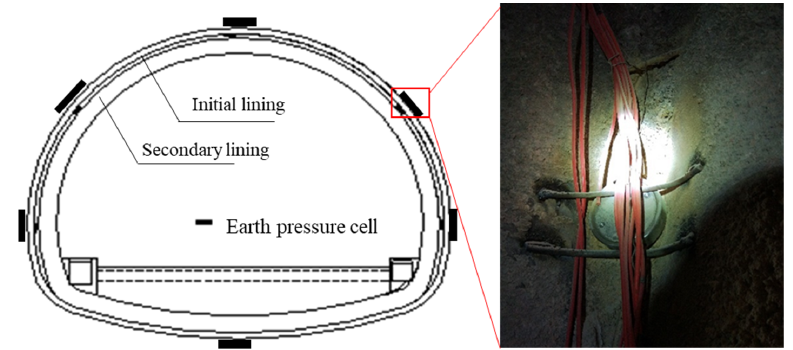
Figure 19. Layout of pressure cells in surrounding rock.